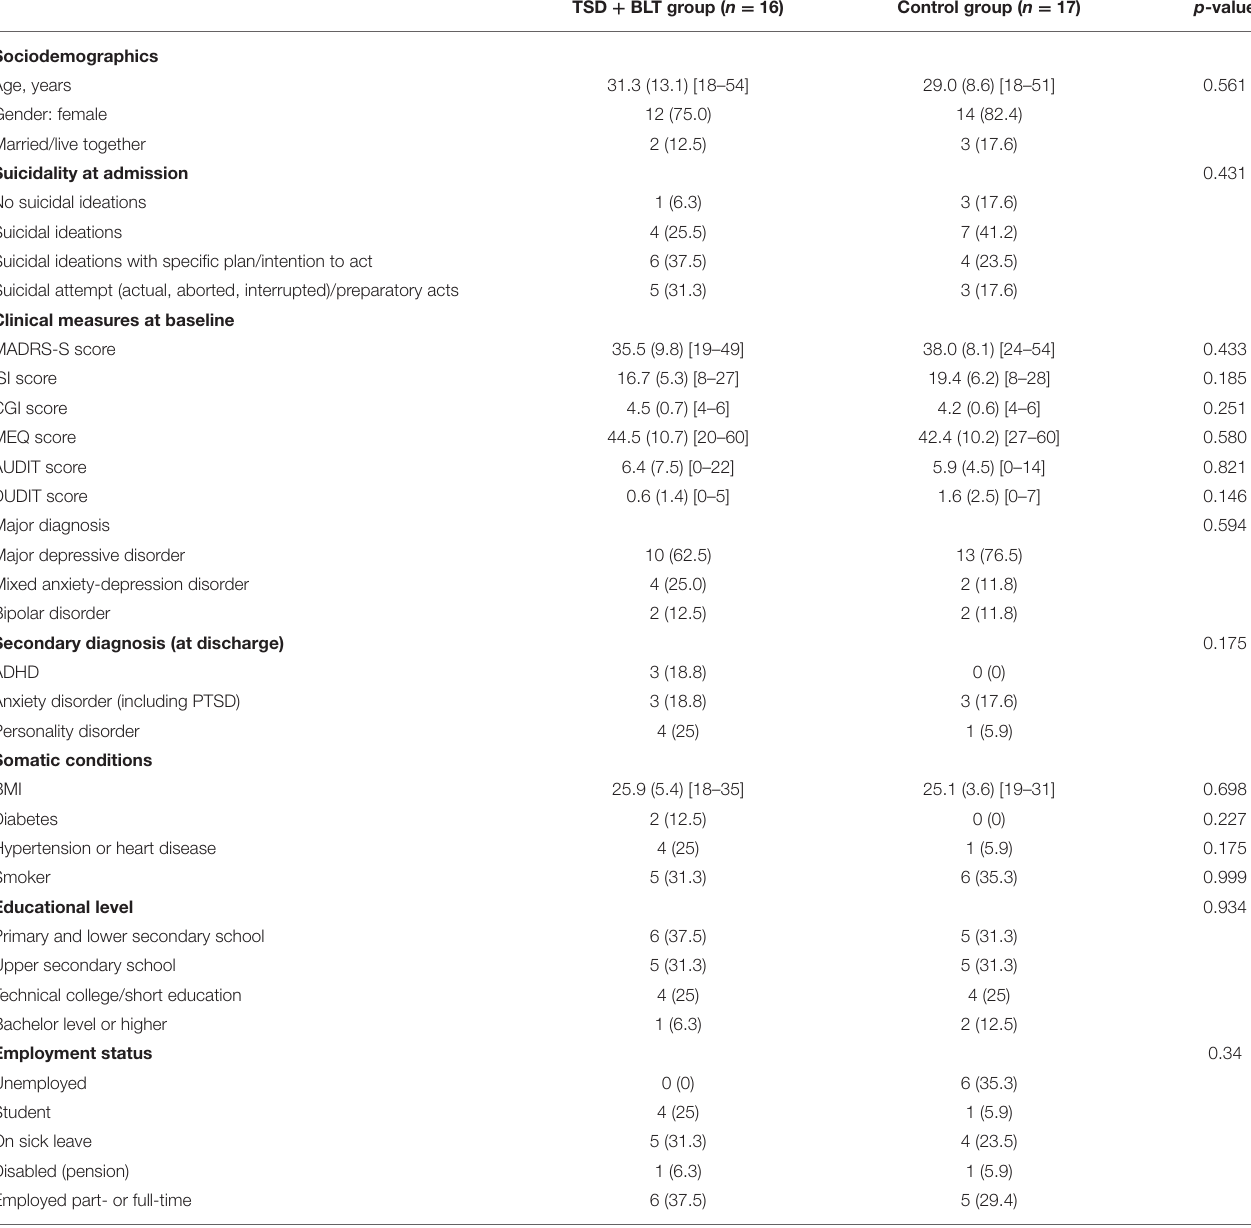
TABLE 2 | Baseline demographic and clinical characteristics ( N =